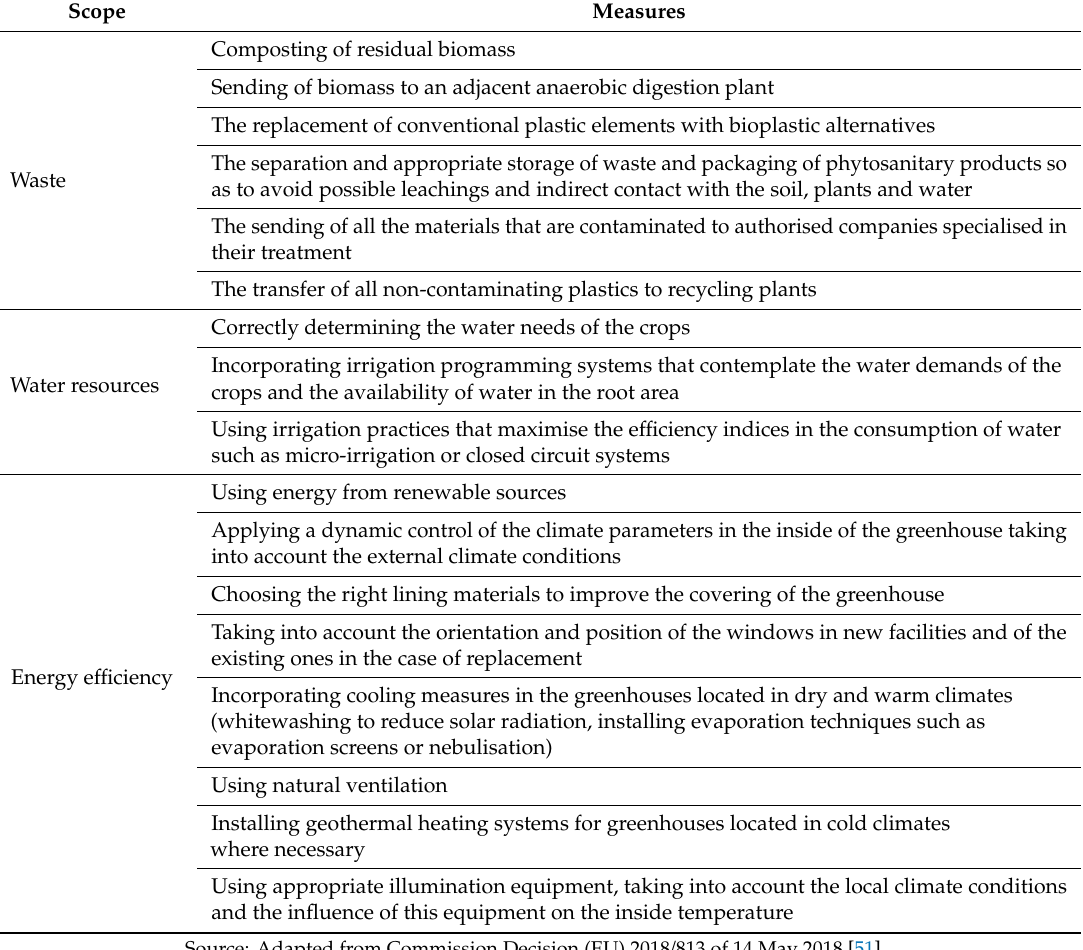
Table 1. Best environmental management practices in greenhouse agriculture.